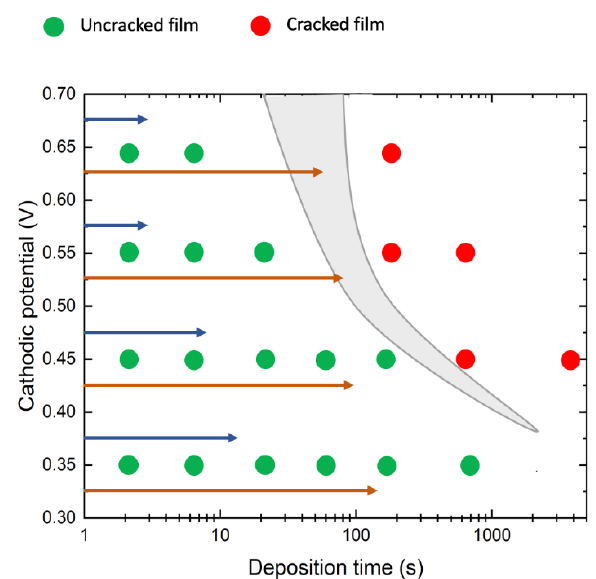
Figure 4. Deposition map: each electrodeposited sample is reported here as a function of V d and t d . The WO 3 films are reported as green or red dots if they result uncracked or cracked, respectively. Per each deposition at fixed V d , two arrows indicate the time extent to get the maximum current (t m , blue arrow) or the saturation current (t s , orange arrow) measured during the electrodeposition (see Figure 5).